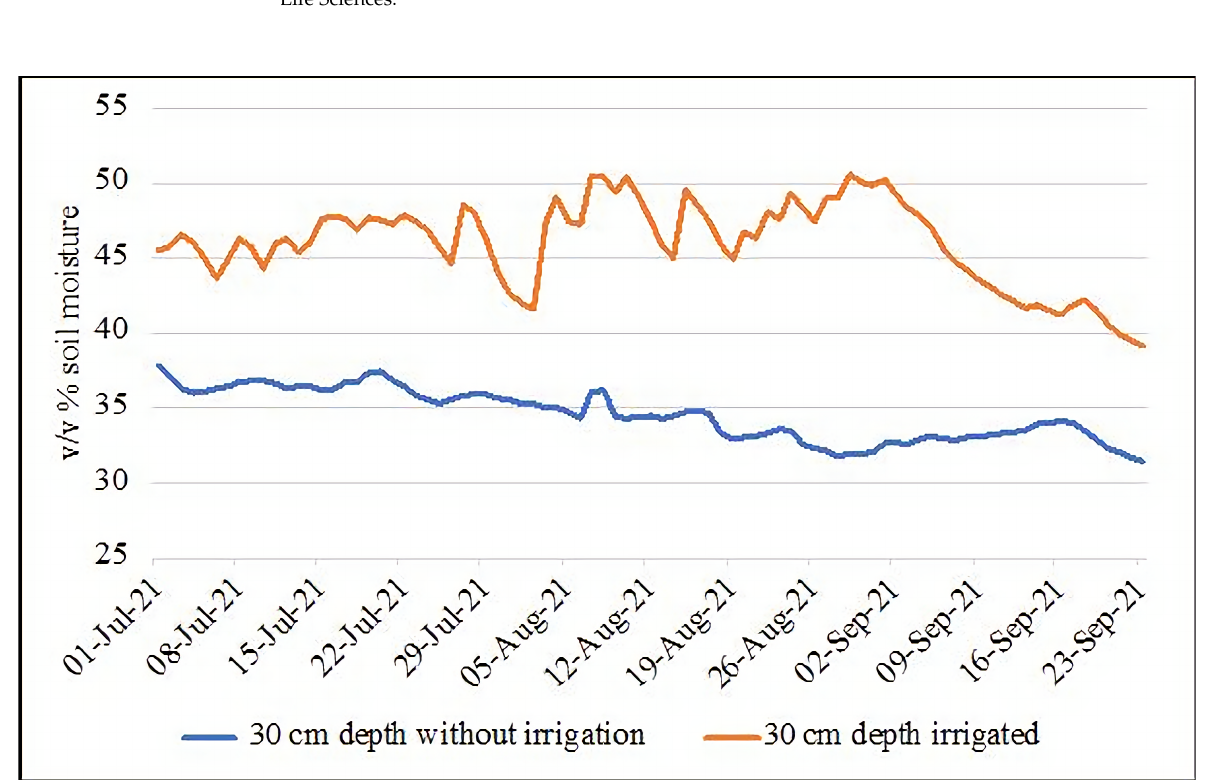
Table 1. Quality parameters of water used for irrigation.